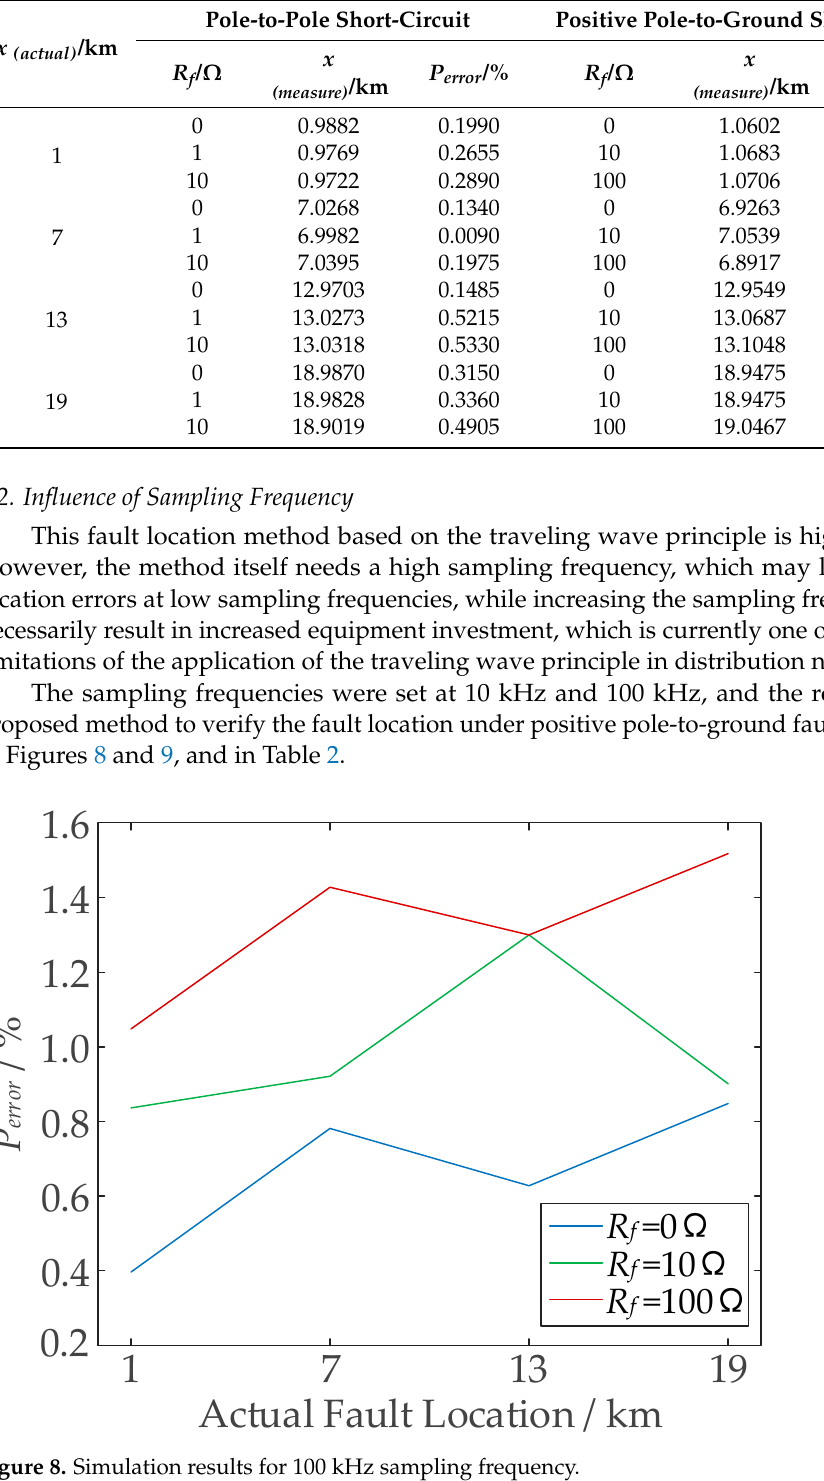
Figure 8. Simulation results for 100 kHz sampling frequency.